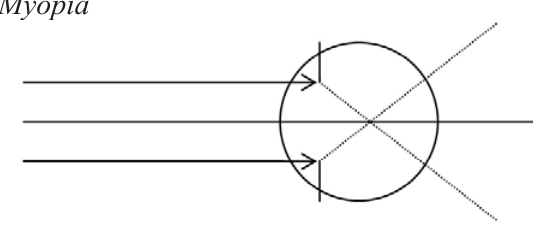
Figure 4 . The myopic eye